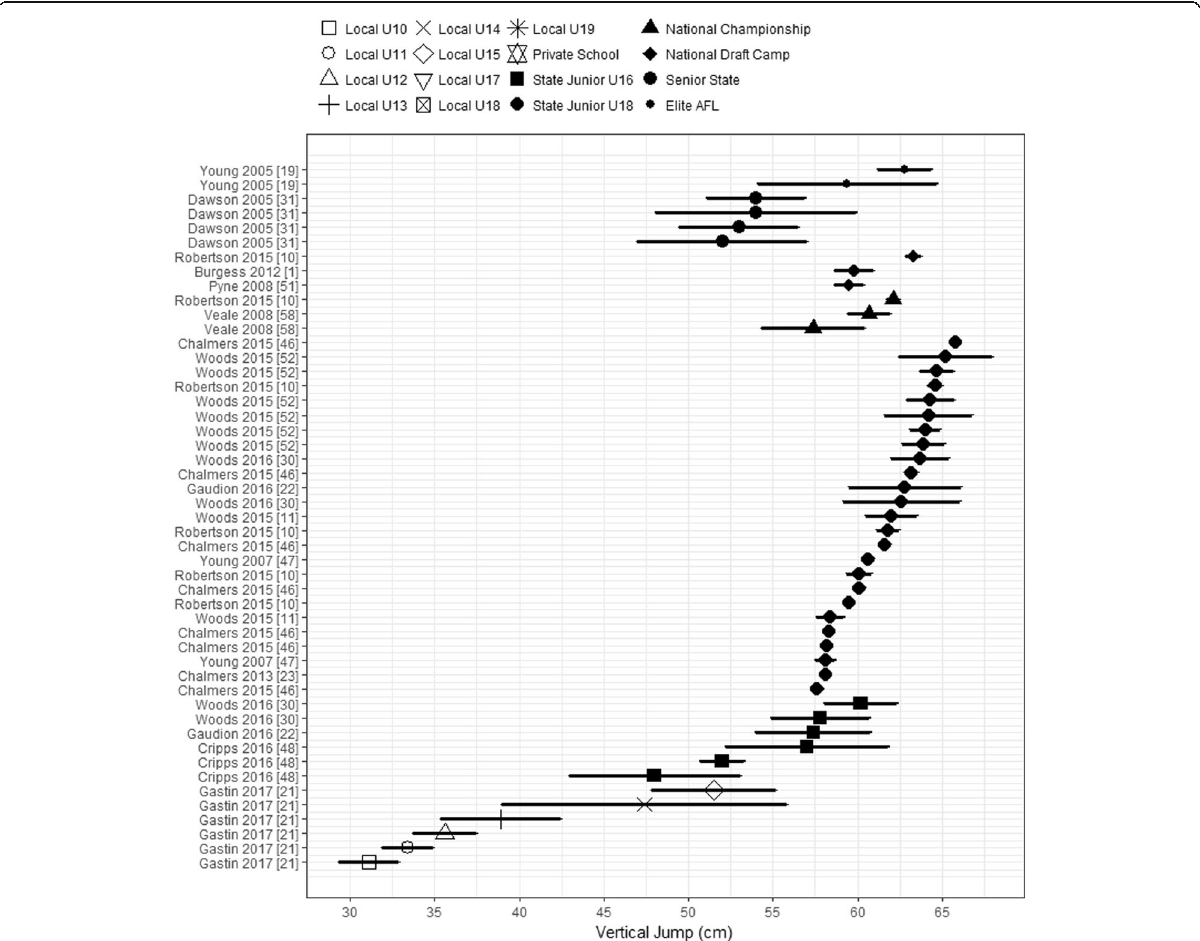
Fig. 5 Mean and CIs of reported countermovement jump height across the AFL participation pathway levels. Values are ordered by position in AFL participation pathway, then by sample size reported for each group. All players ’ levels are shown in the legend for consistency though not all levels may have data on the charted performance measure. AFL Australian Football League, U